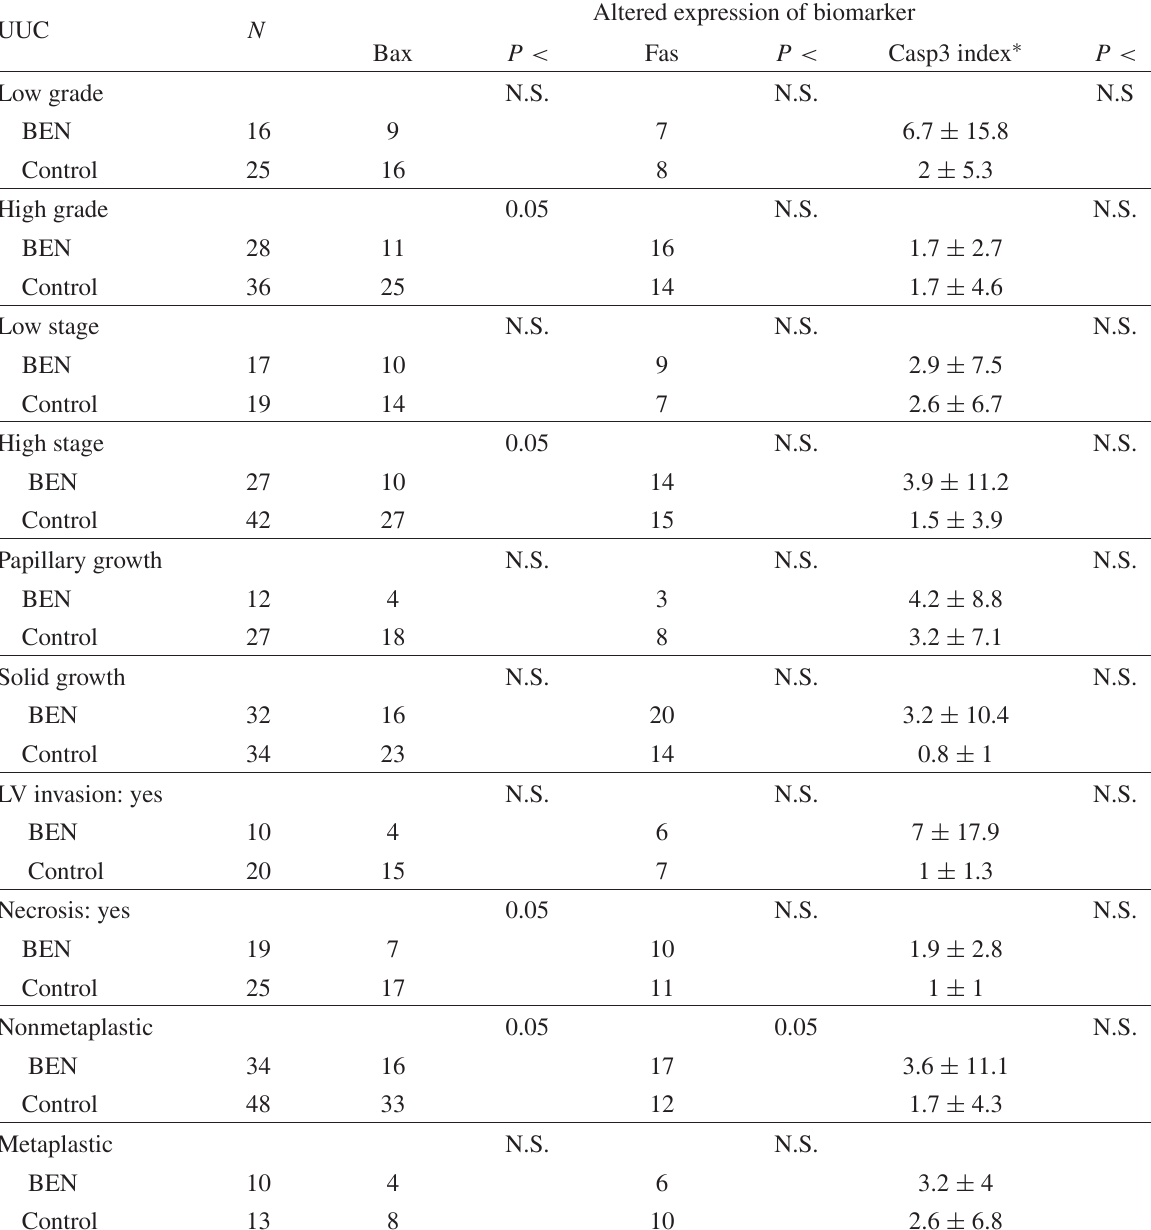
TABLE 2: Association of proapoptotic biomarkers expression with pathological characteristics of